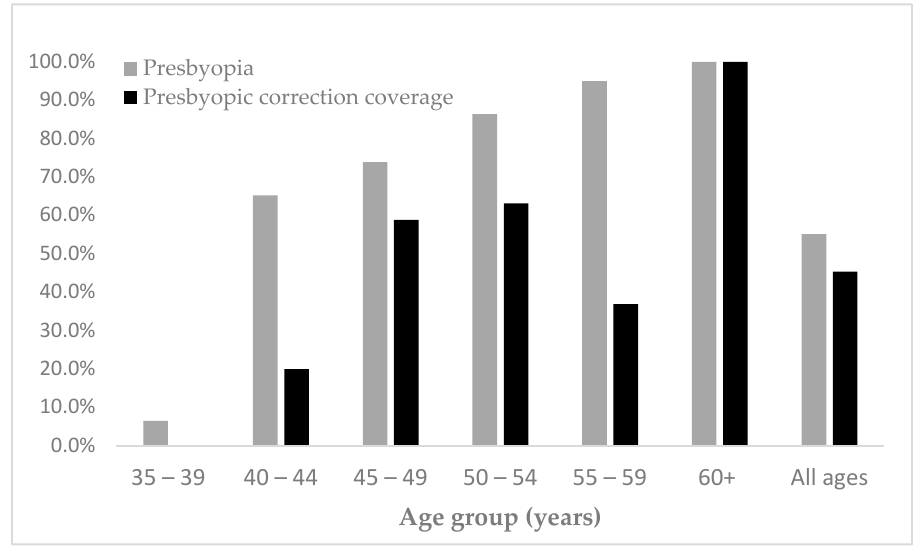
Figure 2. Prevalence of presbyopia and presbyopic spectacle coverage among teachers aged 35 and above, by age.